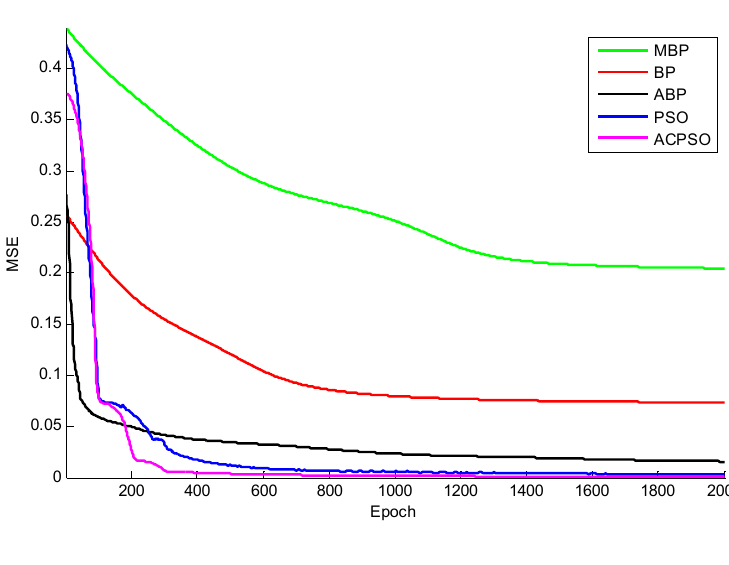
Figure 15. The curve of fitness versus